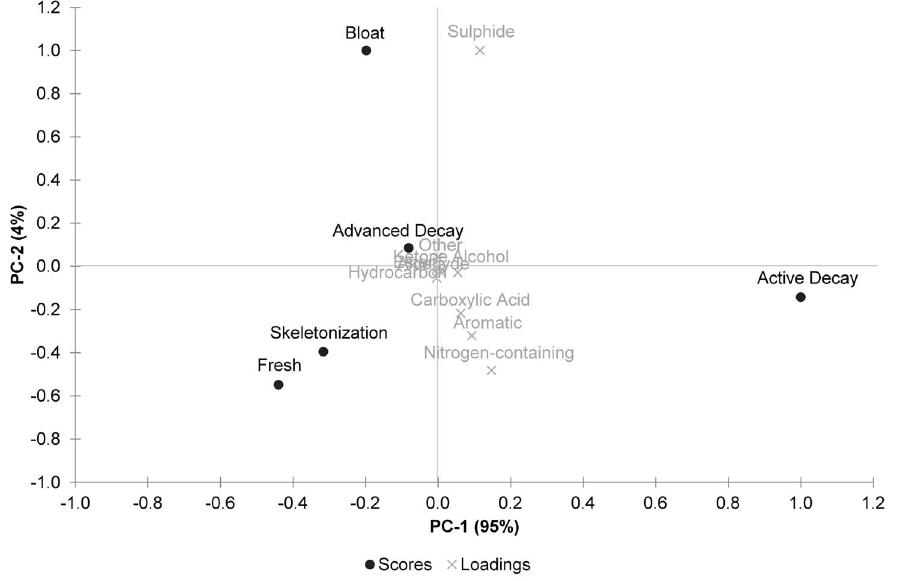
Figure 3. PCA biplot of the calculated scores and loadings for the air experimental samples.